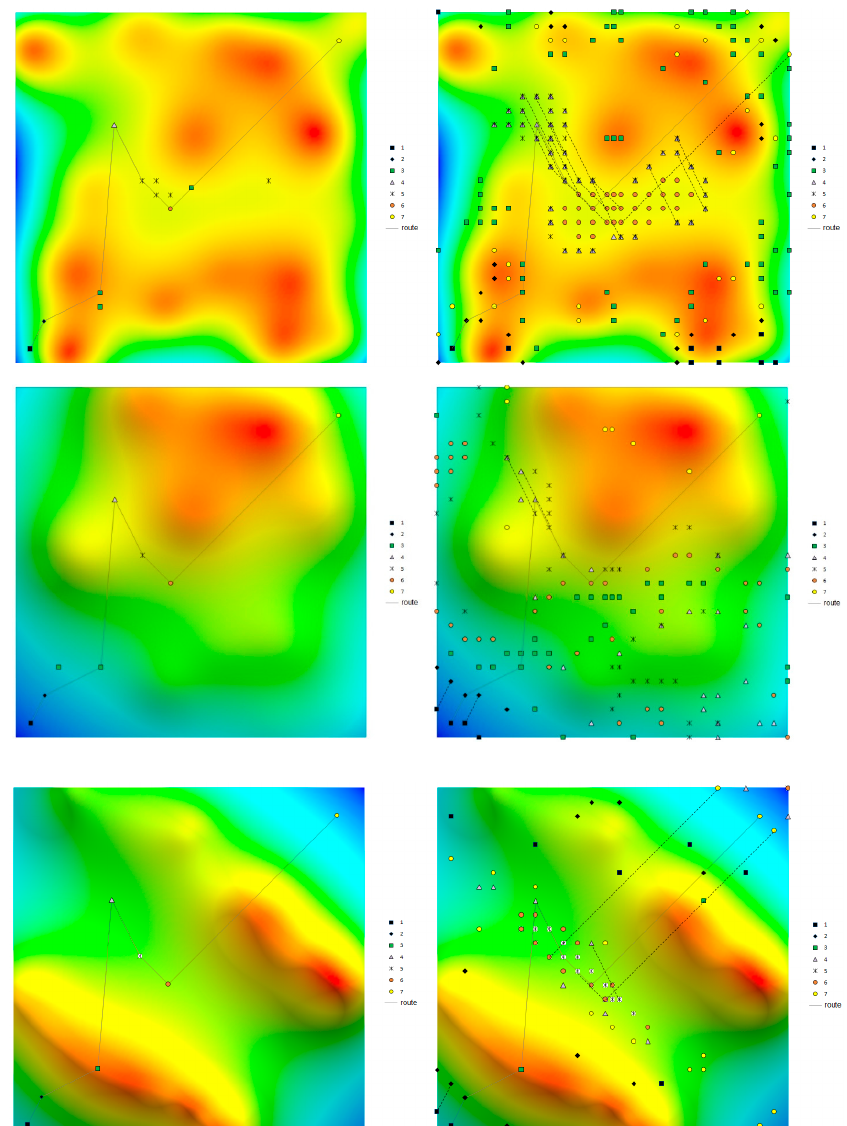
Figure 4. Potential route points found in the regions with low-, medium-, and high-amplitude anomalies